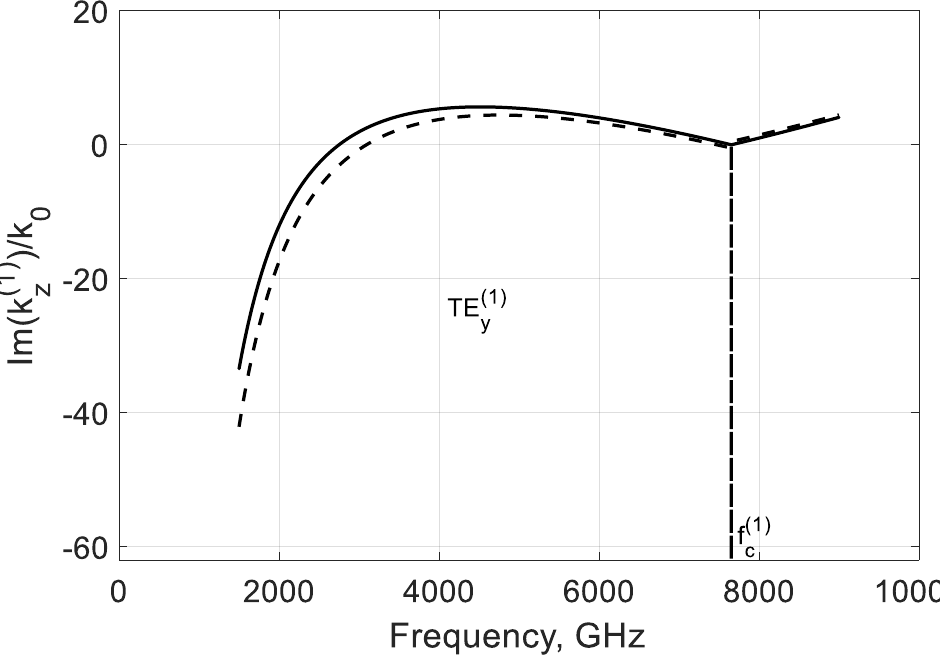
Figure 18. Comparison of an ideal graphene H-waveguide (solid curves) and the one having conductor loss (dash curves) for the first two backward modes. Parameters of the waveguide: b = 0.01 mm, 2 a = ∞ , ε r = 3.84, µ r = 1, conductor conductivity σ = 5.96 · 10 4 Sim/mm, and τ c = 3.6 · 10 14 s for copper. Parameters used for calculation of σ g are from Ref. [21]: T = 300 K, E F = 40 meV, and τ = 1 ps.